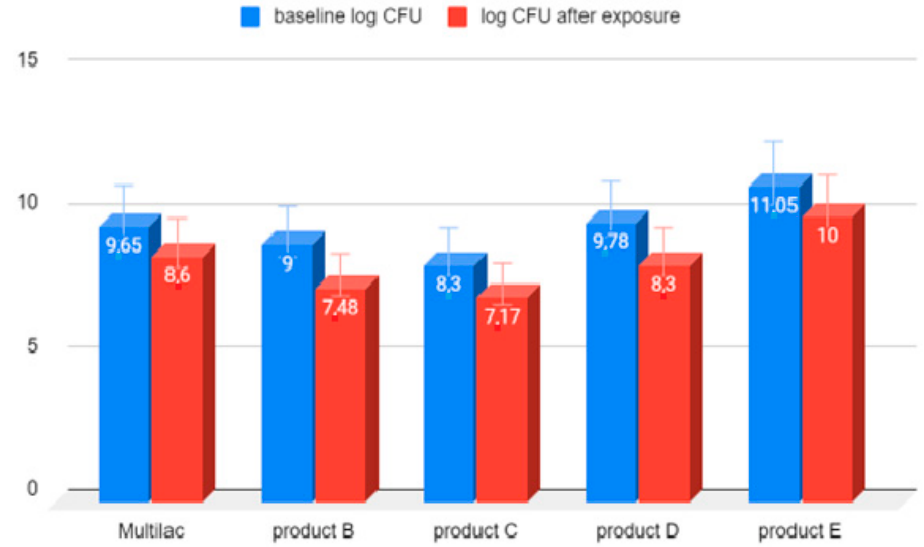
Figure 4. LAB bacterial counts before and after 180 min of exposure to 0.4% bile solution. Arithmetic means of three independent experiments.